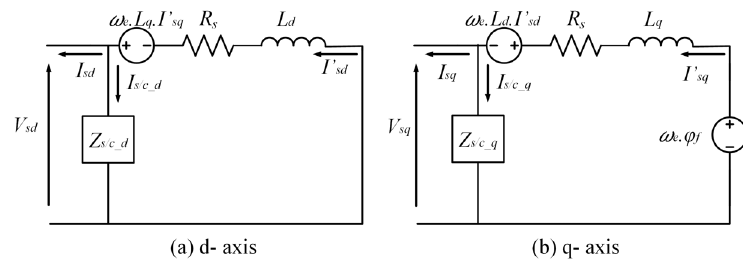
Figure 2. The equivalent circuit of healthy PMSG in the dq-frame.